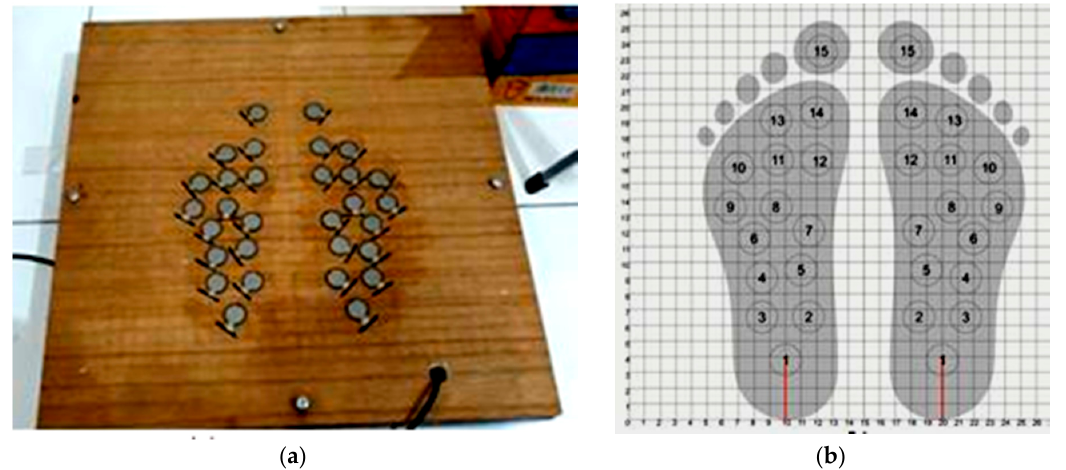
Figure 2. Simple foot static load measuring device: ( a ) measurement platform, ( b ) the location of the sensor placement.